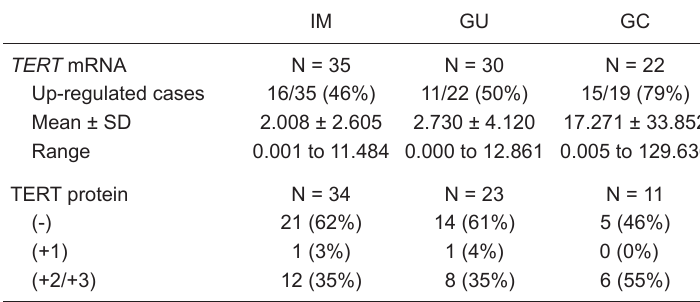
N = number of samples. The Mann-Whitney U - test was used to compare mRNA expression levels and the Fisher exact test to compare protein expression be- tween groups. There were no statistical differences between any pairs of